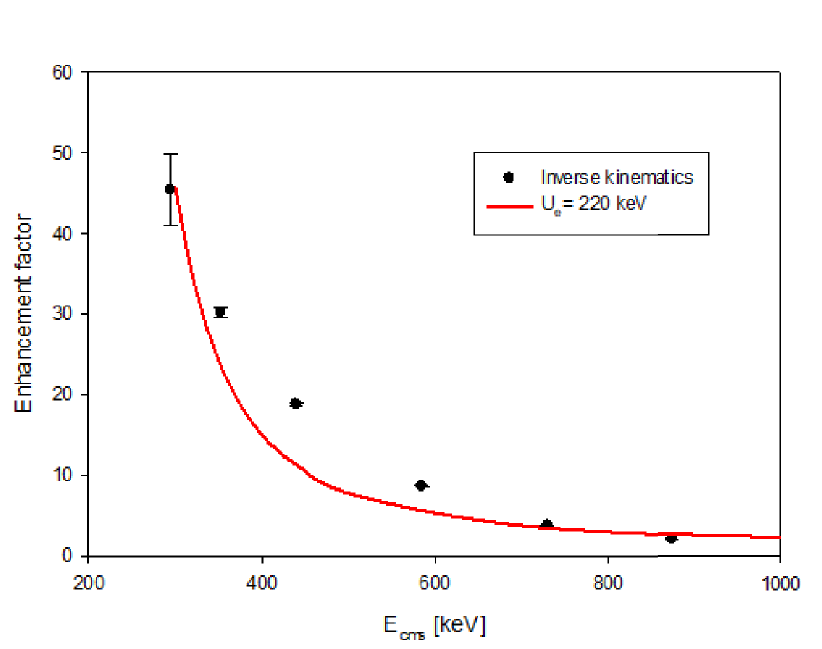
Fig. 3. Cross section enhancement as a function of center of mass energy for the reaction 2 H( 19 F,p) 20 F. The black circles are our measurements on a deuterium implanted titanium target. The red line represents a calculation with U e =220 keV and assumes a constant S -factor. The reaction 1 H( 14 (cid:3)(cid:4)(cid:5)(cid:6) 15 O was recently studied at Helmholz Zentrum